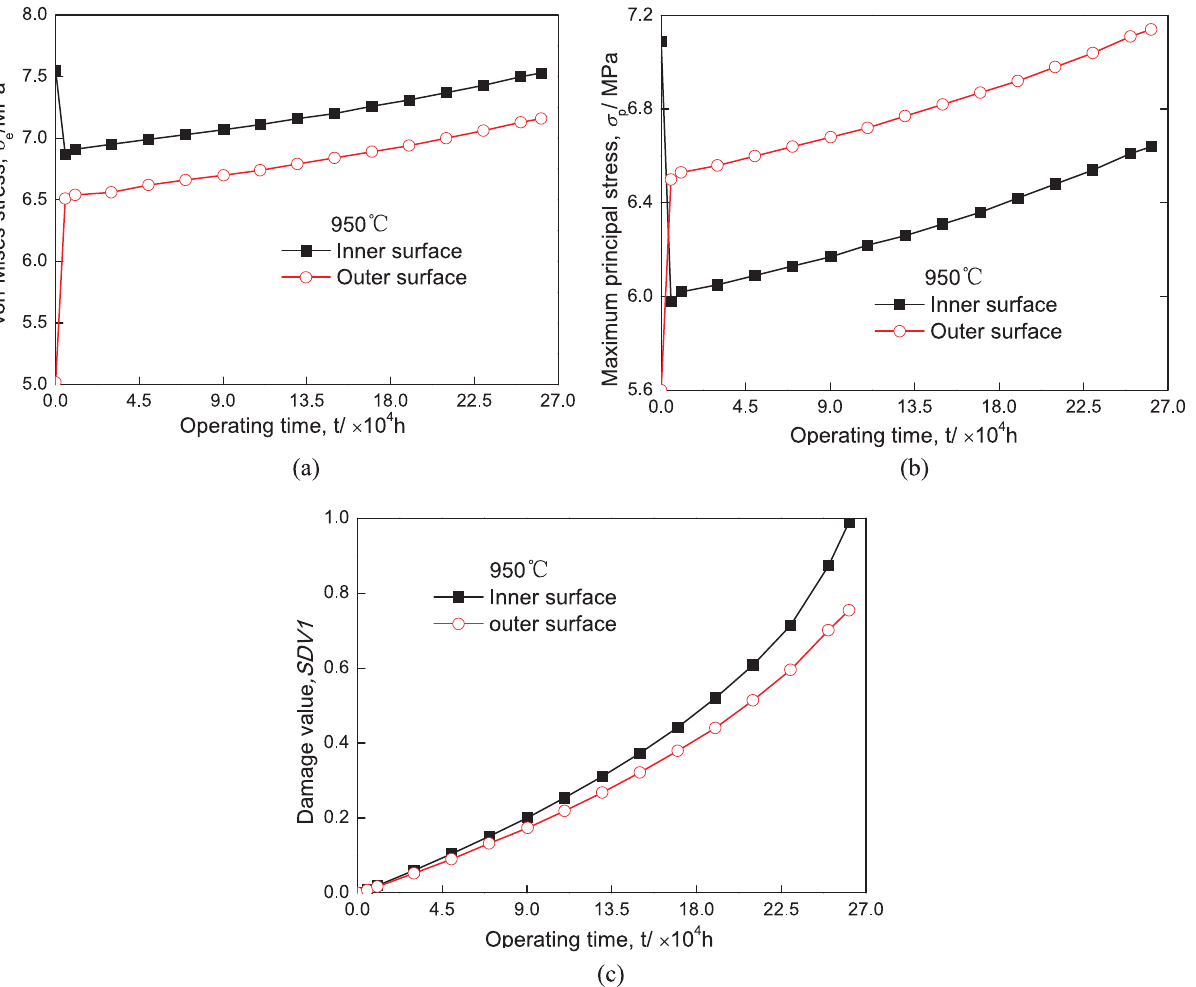
Fig. 9: The evolution of σ e , σ p and SDV1 along inner surface and outer surface of Cr25Ni35Nb alloy tube during the service life at 950 °C: (a) σ e ; (b) σ p ; (c)